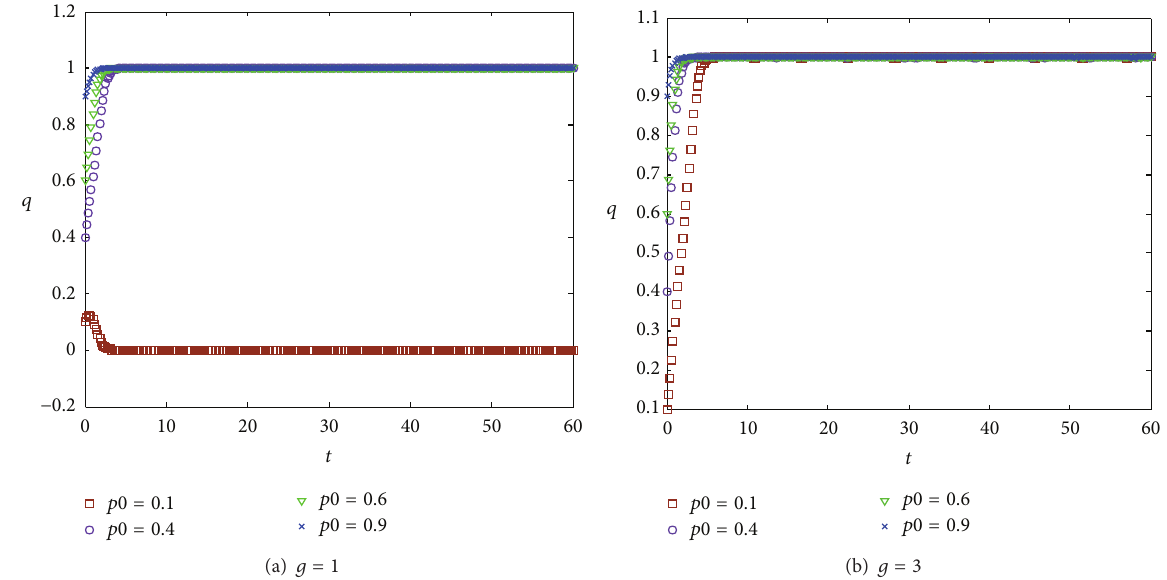
Figure 4: The influence of the government’s positive stimulus on the cooperation strategy.